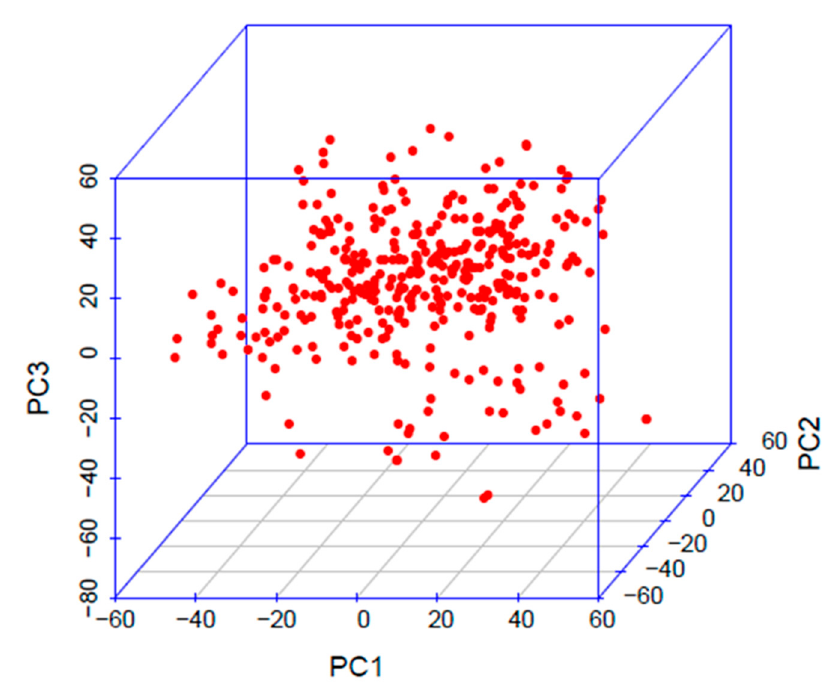
Figure 3. 3D scatter plot of principal component analysis for single nucleotide polymorphisms data of the RiMi panel.